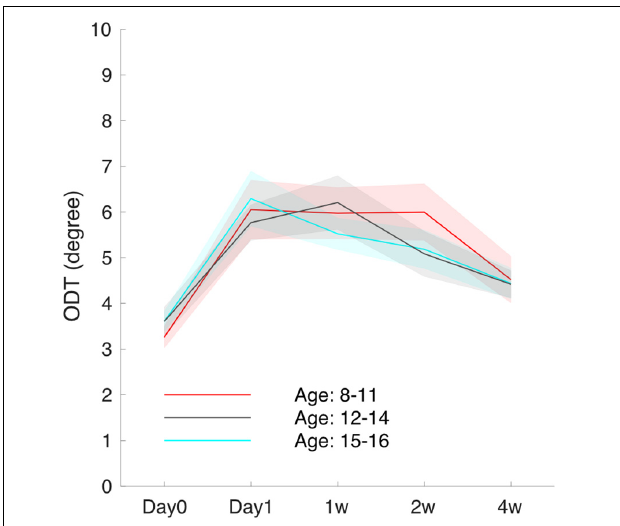
FIGURE 5 | The averaged ODT time course for subjects grouped by age.